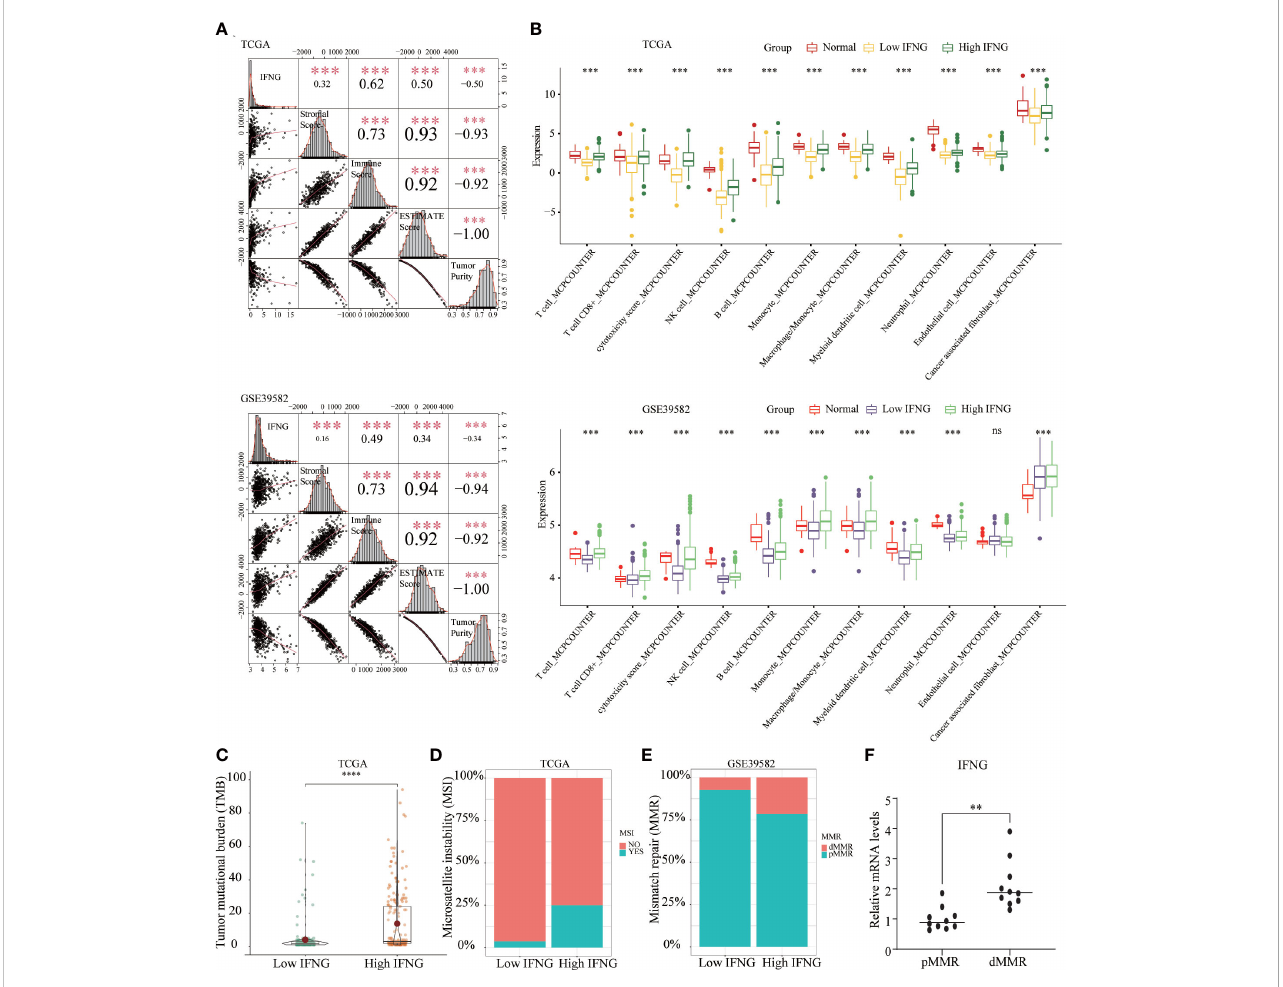
FIGURE 6 The COAD in the high IFNG group tended to be “ hot tumor ” , which were suitable for immunotherapy. (A) IFNG was signi fi cantly and positively correlated with the immune score, stromal score, and ESTIMATE score, while signi fi cantly and negatively correlated with tumor purity. (B) Compared with the low IFNG group, most TIICs in the high IFNG group had higher abundance, and the high IFNG group was more like normal tissues. Compared with the low IFNG group, the high IFNG group had a higher TMB (C) and a higher proportion of MSI (D) and dMMR (E) . (**P-value <0.01; ***P-value <0.001; ****P- value <0.0001).. (F) IFNG mRNA expression in pMMR and dMMR